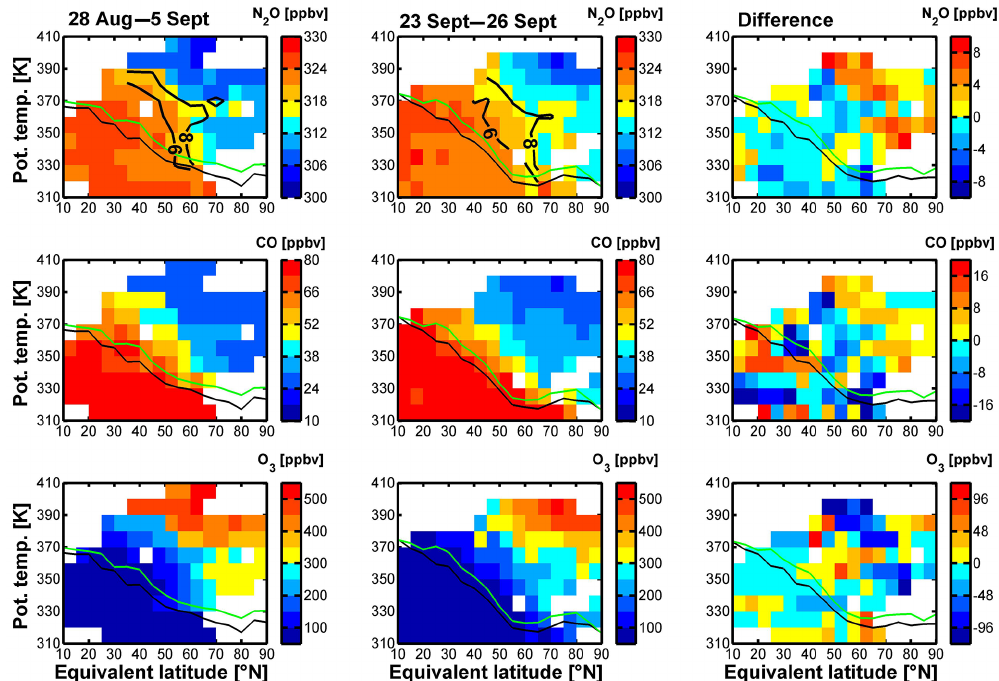
Figure 11. N 2 O, CO, and O 3 distributions in potential temperature (cid:50) and equivalent latitude φ eq coordinates for the TACTS 2012 campaign. Left: distributions for the initial phase of TACTS from 28 August to 5 September. Centre: distributions for the final phase of TACTS from 23 to 26 September. Right: changes in the trace gas distributions during the TACTS 2012 campaign (final minus initial phase). The black and green lines denote the location of the dynamical (PV = 2pvu) and thermal tropopause (WMO, 1957), respectively. The thick black line in the upper array denotes the 6 and 8pvu isolines calculated from ECMWF data along the flight paths.